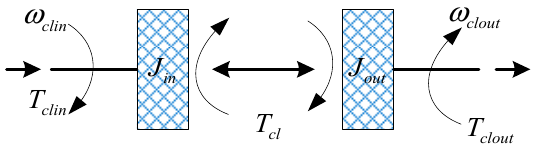
Figure 3. The simplified clutch model in AVL Cruise.